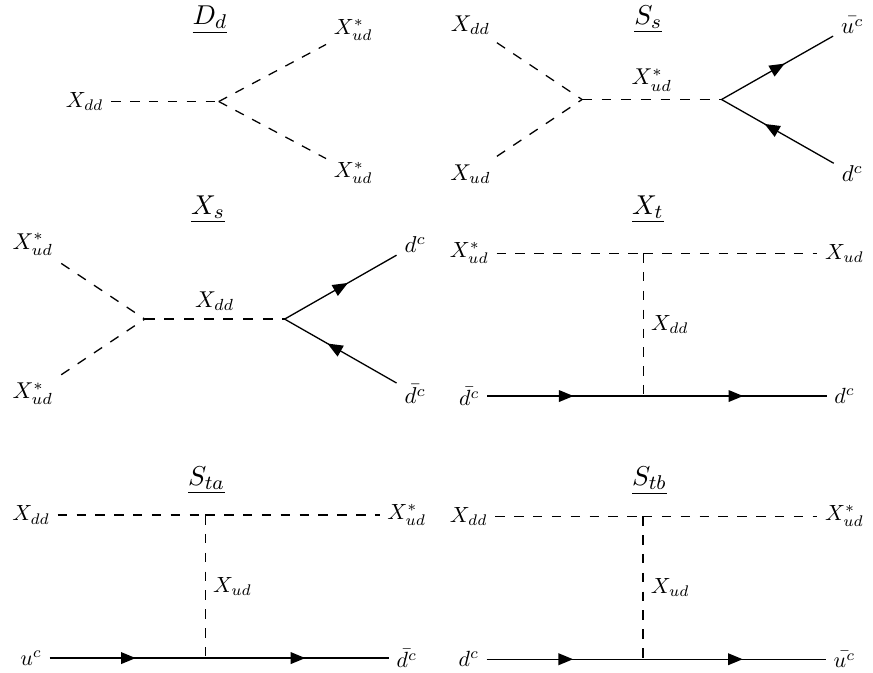
Figure 7 . Baryon number violating scattering and decay diagrams that involve the diquarks X ud and X . The diagrams are here associated with the naming convention used in the Boltzmann dd equation, where the reverse processes are also